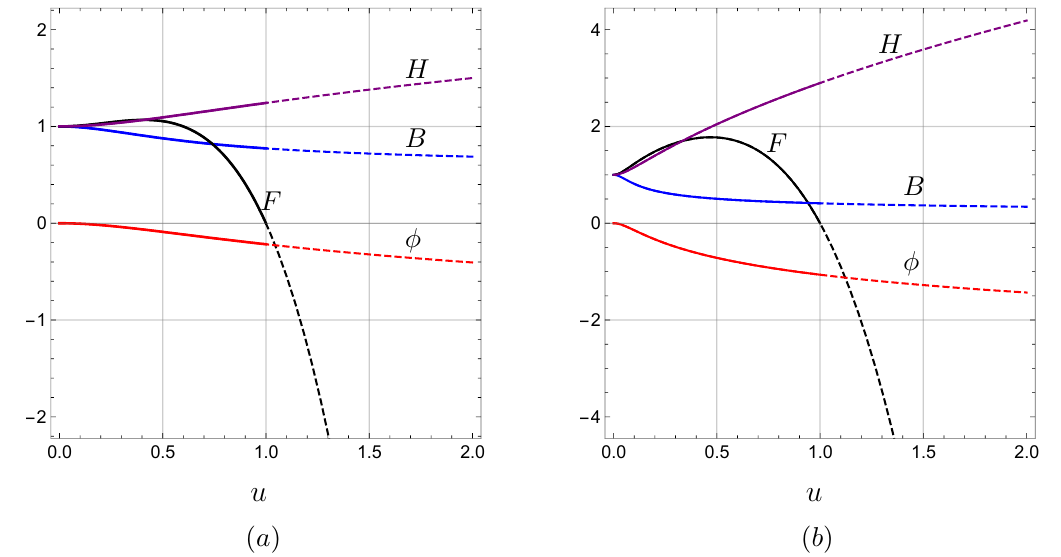
Figure 9 . (a) Metric functions for a=T ’ 4 : 4. (b) Metric functions for a=T ’ 25. The continuous curves represent the result outside the horizon ( u < u results inside the horizon ( u > u